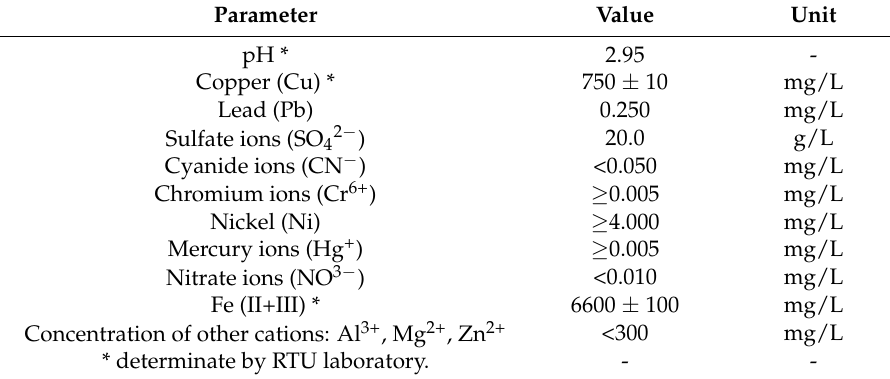
Figure 2. Experimental setup for control experiment of a propeller-type sitter. ( a ) Scheme of process volume with a propeller-type sitter (1), and a laboratory mixer with electric drive (2). ( b ) Propeller-type sitter view. ( c ) Sitter axis located asymmetrically to the vessel. ( d ) Sitter location in processed wastewater volume. Table 1. Physicochemical parameters of the wastewater sample.